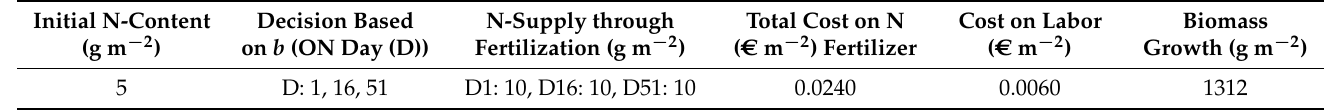
Figure 2. Maximum growth considering the cost of labor and fertilizer. ( a ) Indicates the days when fertilizer delivery is ON, ( b ) displays how much fertilizer is required on these days, ( c ) represents the nitrogen concentration of the soil, ( d ) the NNI level, and ( e ) the progressive development of the biomass. Table 2. Case 1 result: Maximum growth considering the cost of labor and